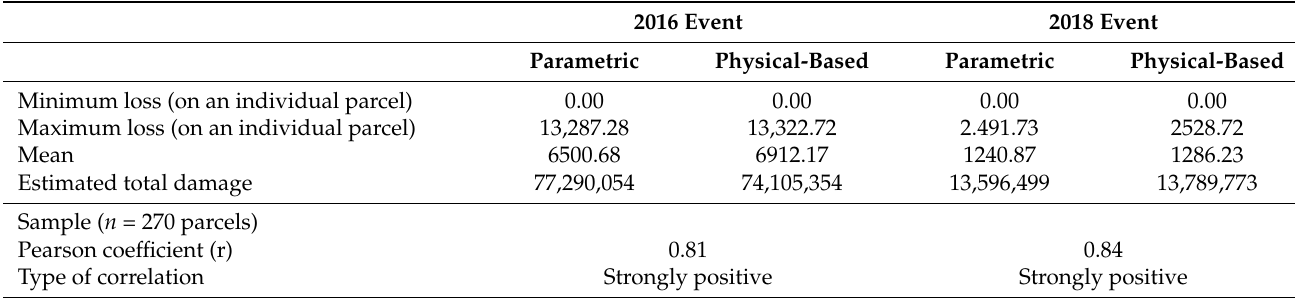
Table 4. Parametric approach comparison using Pearson correlation test with input from simulated damage by the previous physical-based model * (loss is presented in thousand rupiahs).